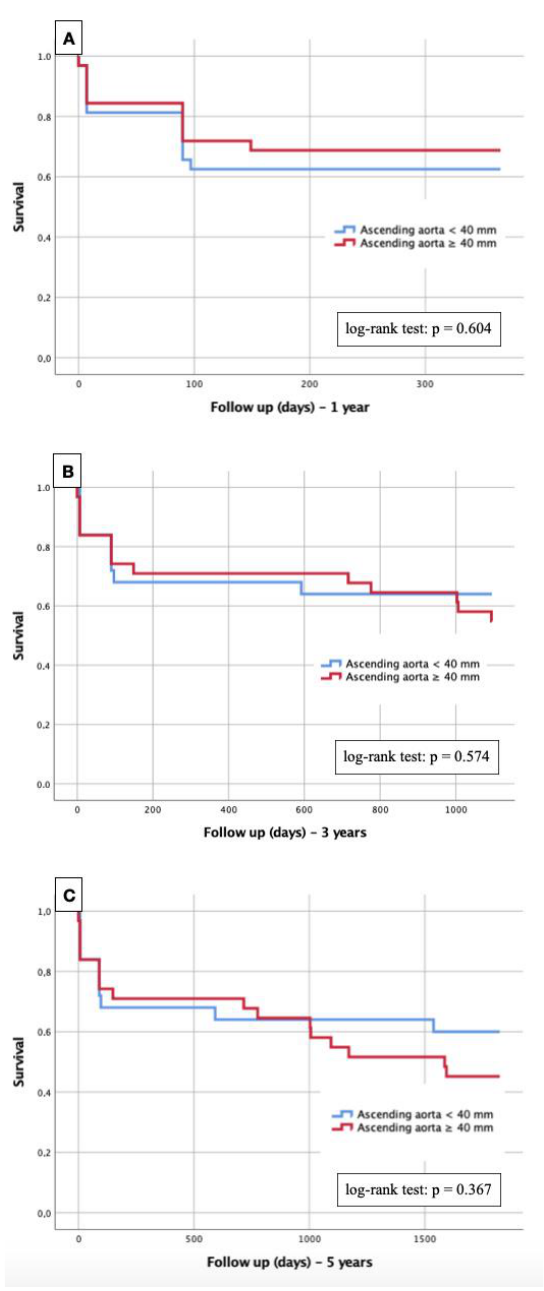
Figure 4. Kaplan–Meier curves for detection of 1-year- ( A ), 3-year- ( B ) and 5-year-survival ( C ) in terms of dependence on an AA diameter cut- off value ≥ 40 mm.